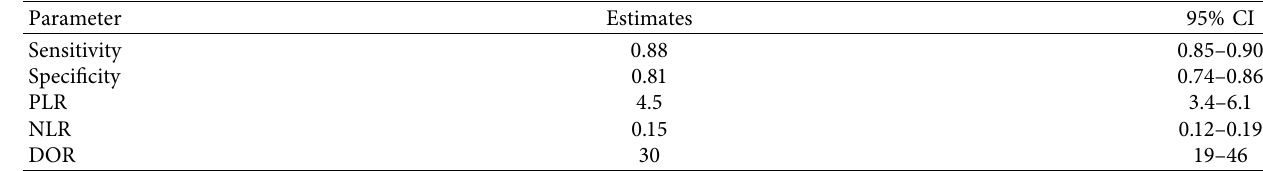
Table 2: Summary performance estimates.